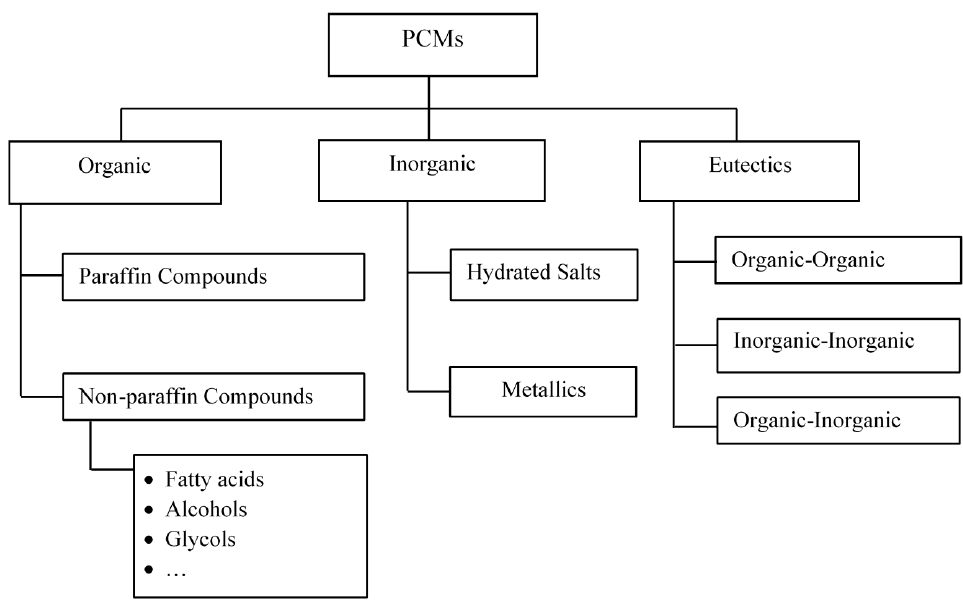
Figure 4. Classification of phase change materials (PCMs) [19].